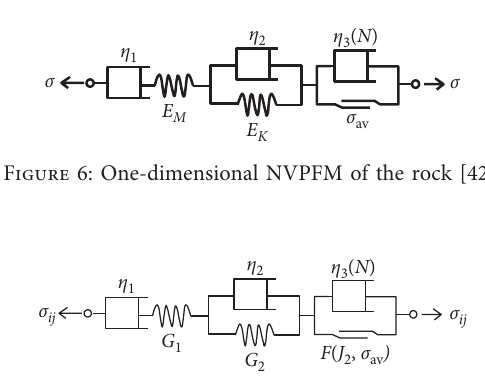
Figure 7: Three-dimensional NVPFM for the rock.